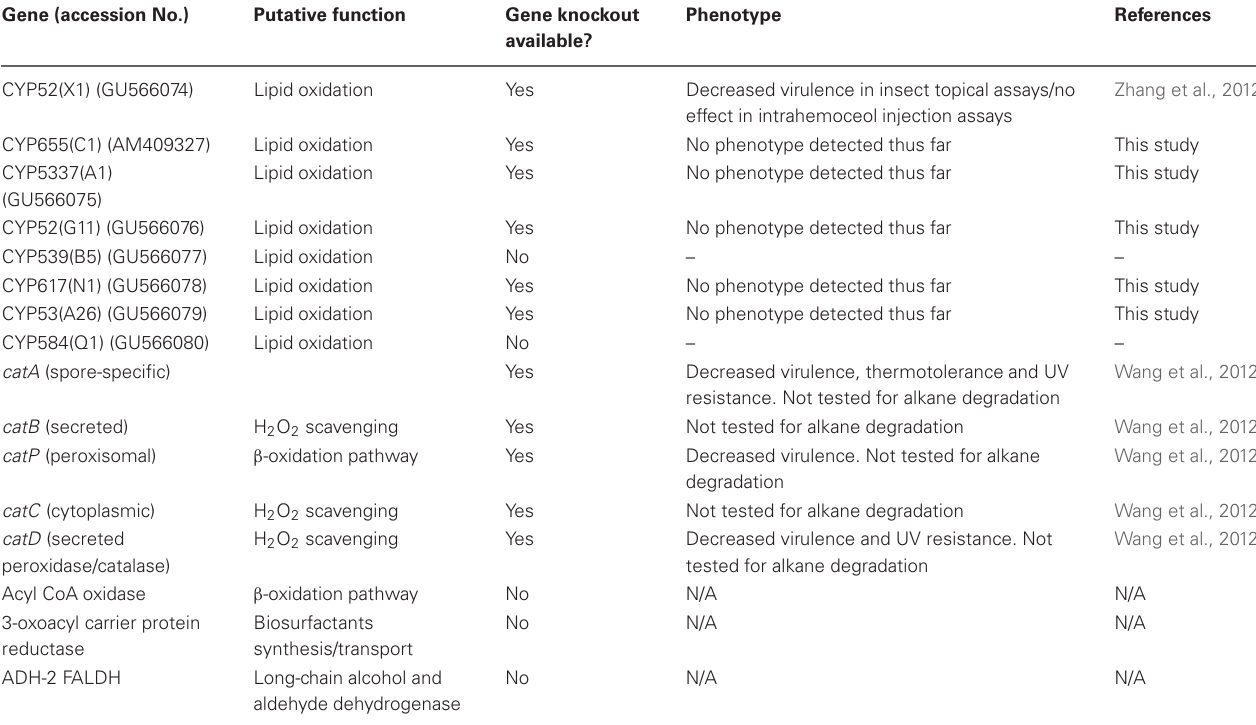
Table 1 | Candidate genes involved in alkane degradation identified in the B. bassiana EST dataset. Gene (accession